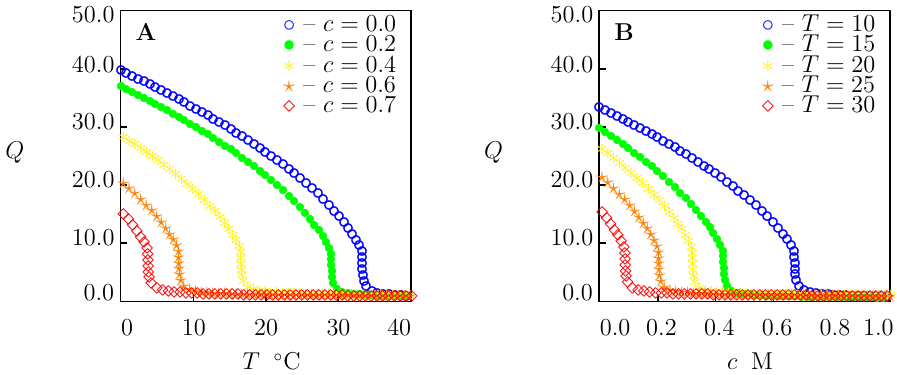
Figure 12. ( A )—Equilibrium degree of swelling Q versus temperature T . ( B )—Equilibrium degree of swelling Q versus concentration of salts c in aqueous solutions. Symbols: predictions of the model for PNIPAAm gel in solutions of CaCl 2 with various concentrations c M at various temperatures T ◦